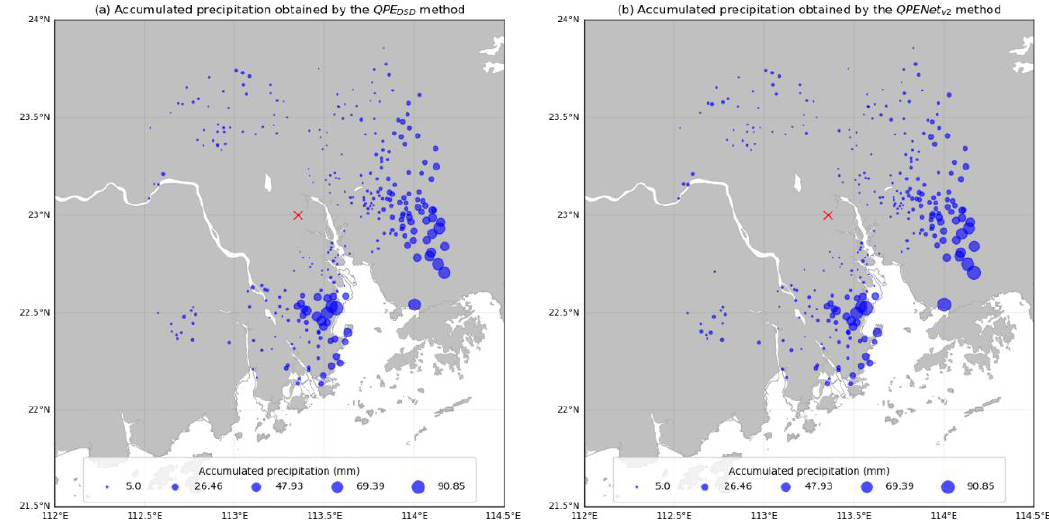
Figure 7. The same as Figure 6, but for the accumulated rainfall during the whole event.